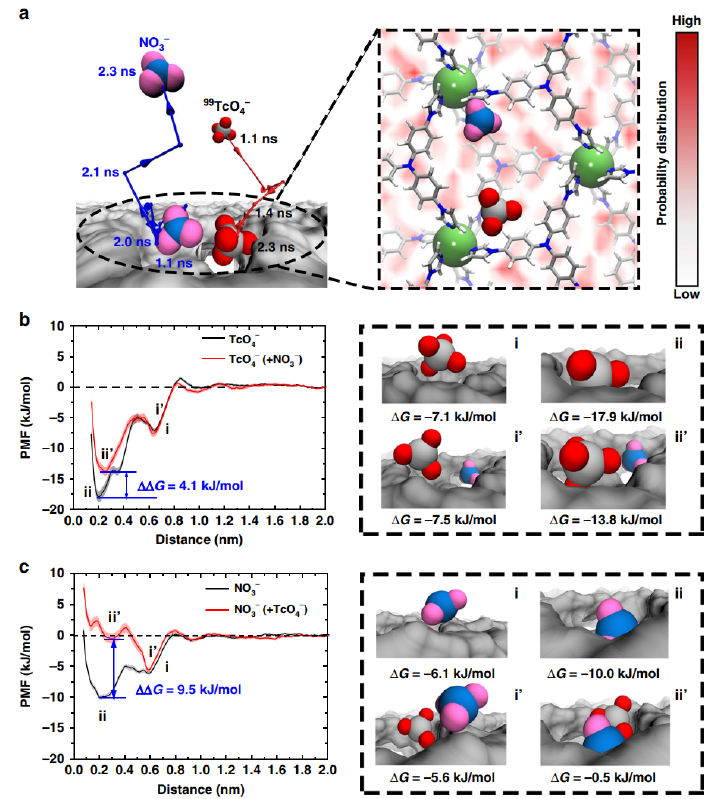
Figure 10. Binding free energies of 99 TcO 4 − and NO 3 − to their most energetically favorable sites in SCU-103. ( a ) A representative anion-exchange process of NO 3 − by 99 TcO 4 − (left). The red and blue lines with arrows represent the center of mass motion trajectory of 99 TcO 4 − and NO 3 − from 1.1 ns to 2.3 ns. The most important crucial intermediate state during the anion-exchange process is shown when 99 TcO 4 − binds to its final binding site, while NO 3 − dwells at its original binding site (right). The color gradient of the background demonstrates the binding probability distribution of NO 3 − to SCU-103, and ranges from the lowest probability (0, white) to the highest probability (0.110, red). ( b , c ) Binding free energies of 99 TcO 4 − /NO 3 − alone to its final binding site (black curves), and the binding free energies of the two anions at the crucial intermediate state (red curves). Snapshots highlighted by the black dashed lines represent the typical binding configurations of − /NO − anions to SCU-103 corresponding to the energy minima in the free energy curves. 99 TcO 4 3 The shadows in ( b , c ) represent the predictive error of the binding free energy profiles [12],